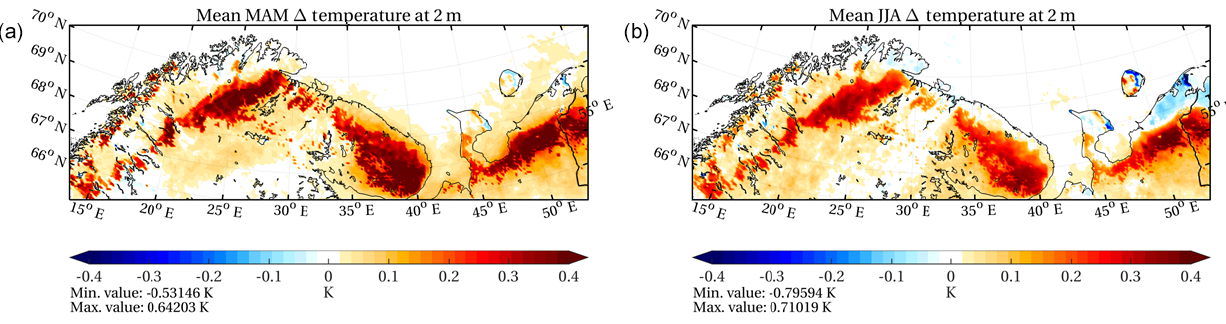
Figure 11. Effects of increased shrub cover (Veg1K–RefVeg) on the 2m temperature resulting from a shrub and tree cover increase corre- sponding to a 1K warming of JJA temperatures (only showing significant results at the 95% confidence level, as in Fig. 4). Mean spring season response is shown in panel (a) and mean summer season response is shown in panel (b)